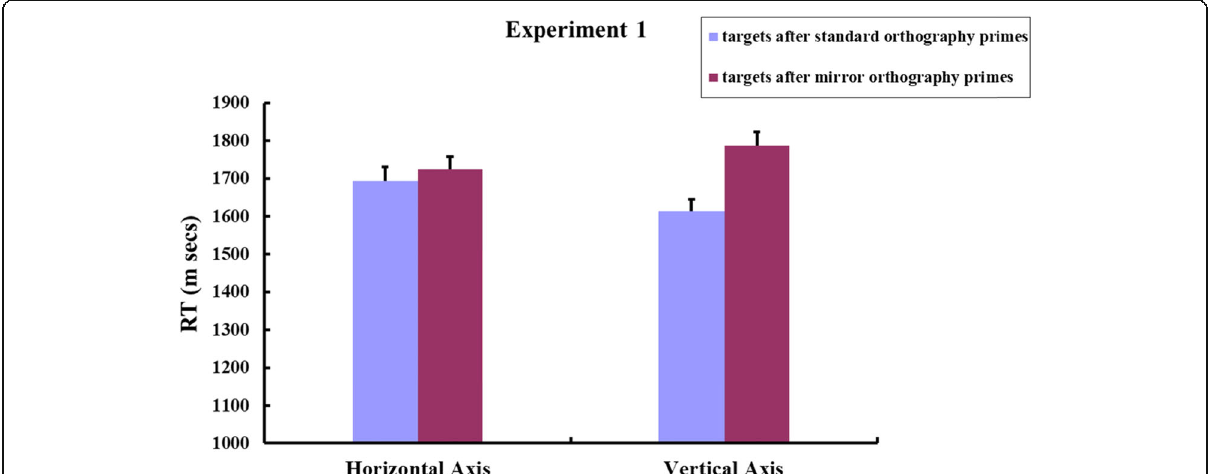
Fig. 5 Experiment 1: Mean RTs for targets after the horizontal standard-orthography/mirror-orthography primes and the vertical standard- orthography/mirror-orthography primes by Japanese speakers. The figure plotted by participants ’ mean RTs. Error bars indicate standard errors of the